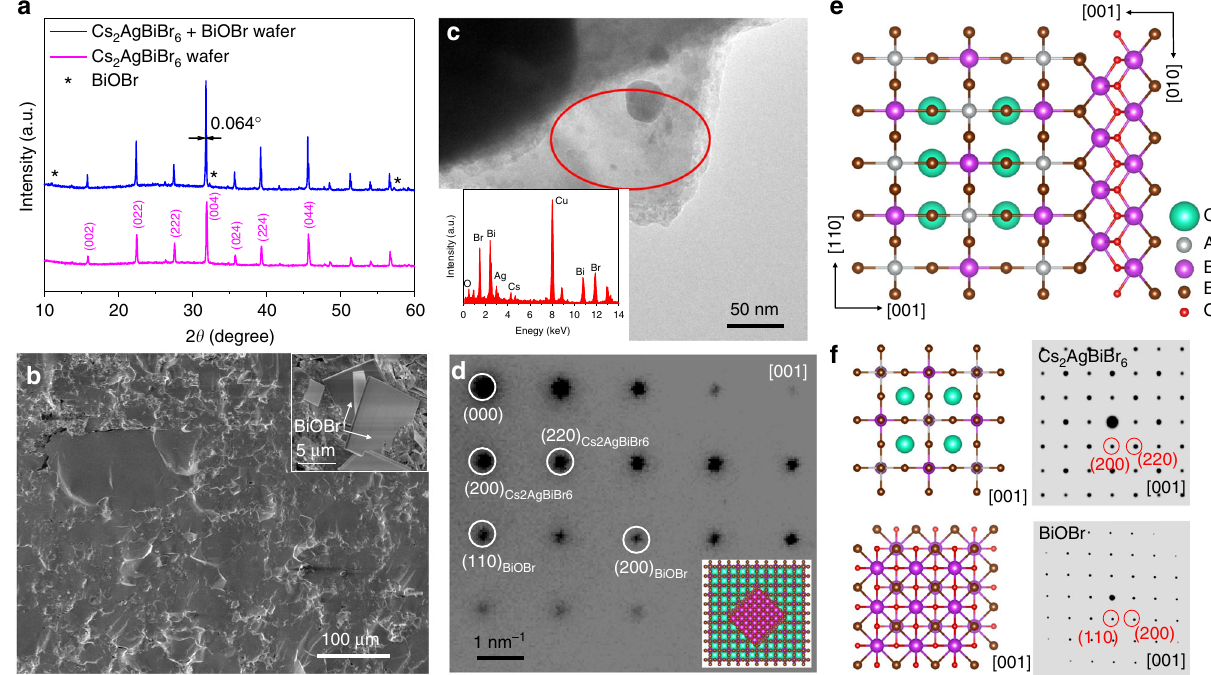
Fig. 2 Structural determination of BiOBr-passivated Cs 2 AgBiBr 6 wafer. a XRD spectra of the wafers with/without BiOBr passivation. b Cross-sectional SEM image of the BiOBr-passivated Cs 2 AgBiBr 6 wafer, the inset is the top view. c TEM image of the selected region containing both BiOBr and Cs 2 AgBiBr 6 , the inset is the EDS result to verify the presence of Bi, O, Br, Cs, and Ag elements. d SAED pattern of the selected region in c , and the inset is the epitaxial growth model. The corresponding diffraction spots from Cs 2 AgBiBr 6 and BiOBr are labeled accordingly, and the zone axis is [001]. e Epitaxial growth direction between BiOBr and Cs 2 AgBiBr 6 . f Crystal structure of Cs 2 AgBiBr 6 and BiOBr viewed from [001] directions and the related diffraction